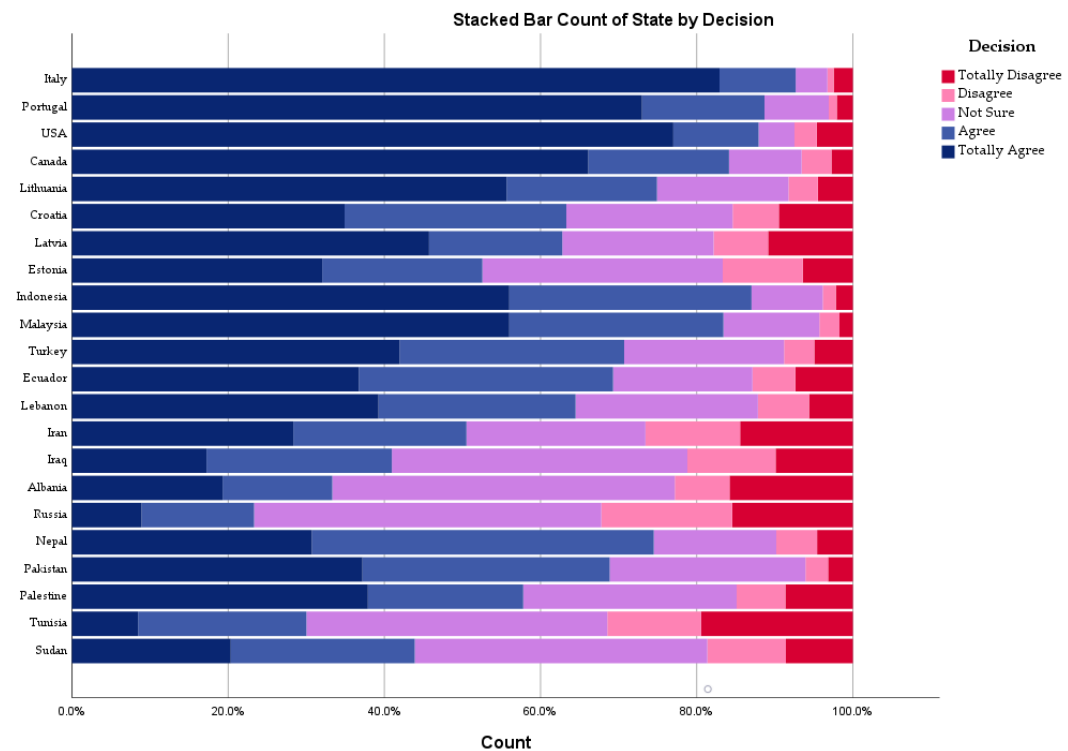
Figure 1. Dental students’ COVID-19 vaccine acceptance level by state, February 2021. Africa was the least accepting region (3.18 ± 1.2), followed by Eastern Mediterranean (3.5 ± 1.29), and the Americas was the most accepting region (4.15 ± 1.15). Across the economic ranking, the vaccine acceptance level was gradually distributed with the least accepting being the low-income group (3.37 ± 1.17), and the most accepting being the high-income group (4.36 ± 1.07). The difference between the lower-middle-income group (3.63 ± 1.23) and upper-middle-income group (3.66 ± 1.25) was slight and statistically insignificant ( U = 1,833,237; p = 0.302) (Figure 2). Regarding their COVID-19-related experience, the students who had been previously infected were significantly ( U = 2,677,855; p < 0.01) less accepting (3.57 ± 1.36), also the students who provided care to COVID-19 patients were significantly ( U = 4,004,539; p < 0.01) less accepting (3.68 ± 1.31). However, having a COVID-19 patient within students’ social circles was significantly ( U = 2,219,499; p < 0.01) associated with a higher acceptance level of COVID-19 vaccine (3.86 ± 1.24), and having a deceased COVID-19 patient within students’ social circles was significantly ( U = 5,175,777; p < 0.01) lowering the COVID-19 vaccine acceptance (3.77 ± 1.26) (Table